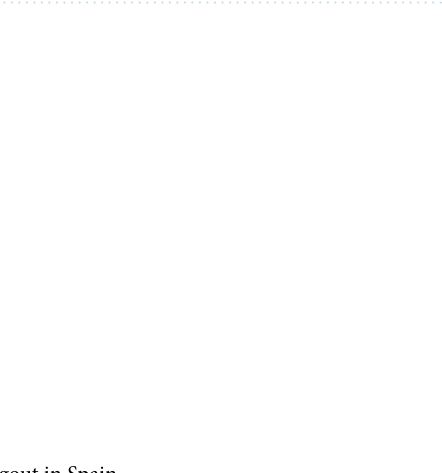
Table 1. Mean hospital stays and in-hospital mortality for gout in